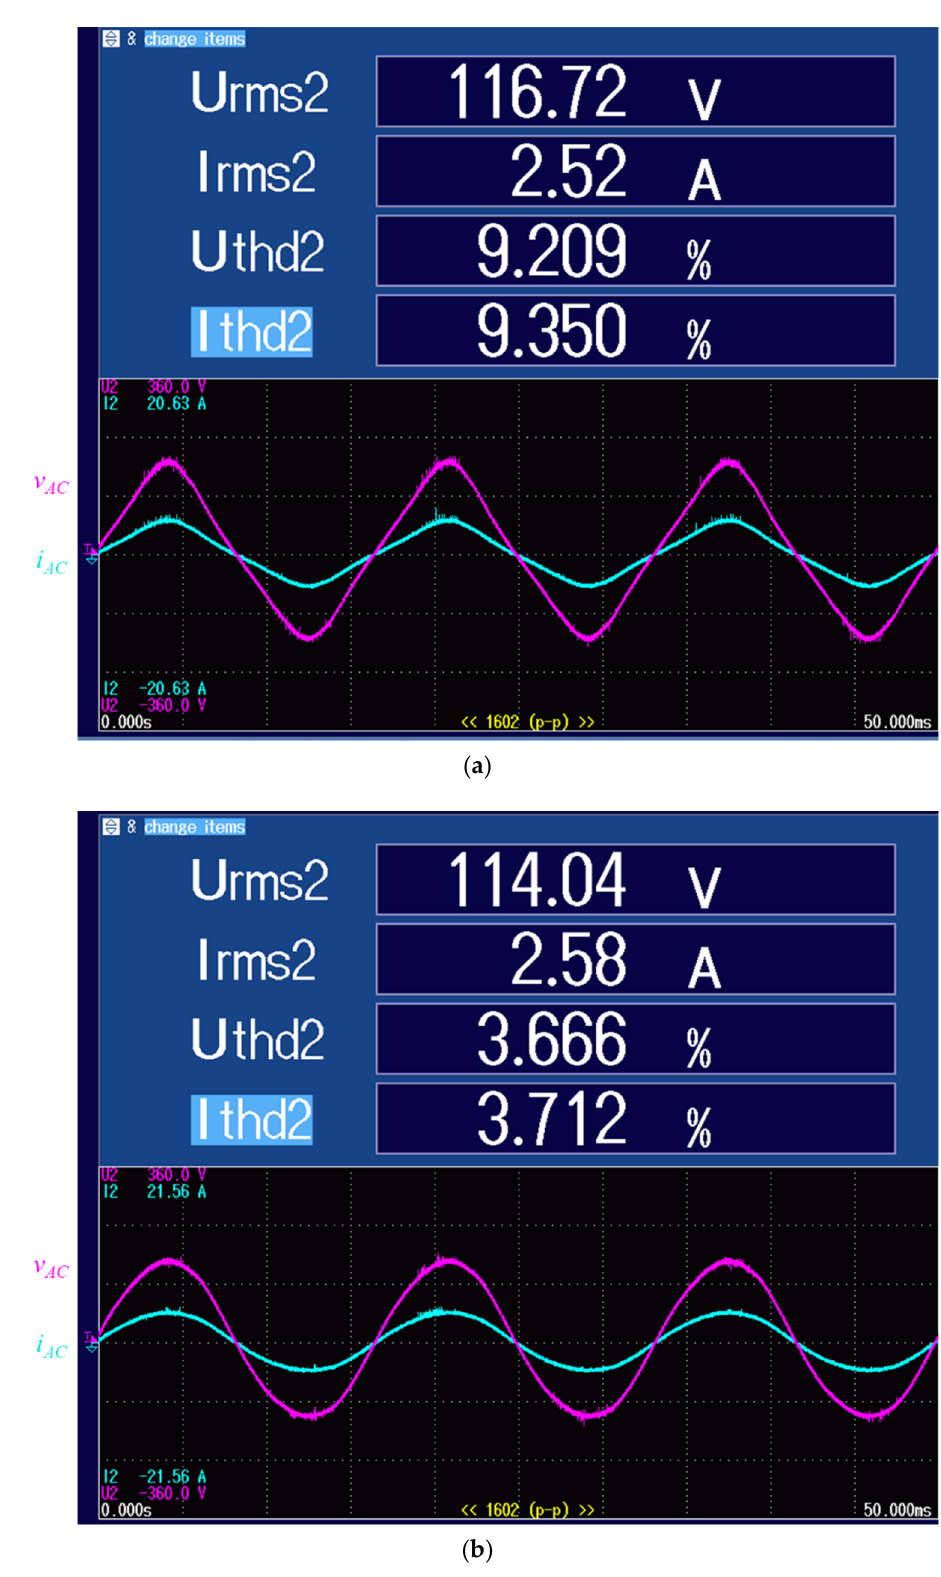
Figure 24. THD analysis in hardware experiments (250 W) when using ( a ) the traditional SPWM control and ( b ) modified SPWM control.